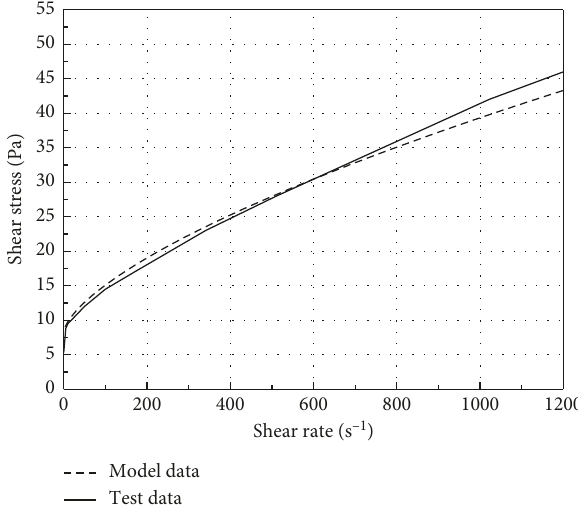
Figure 7: The flow curves calculated by the HB model and the